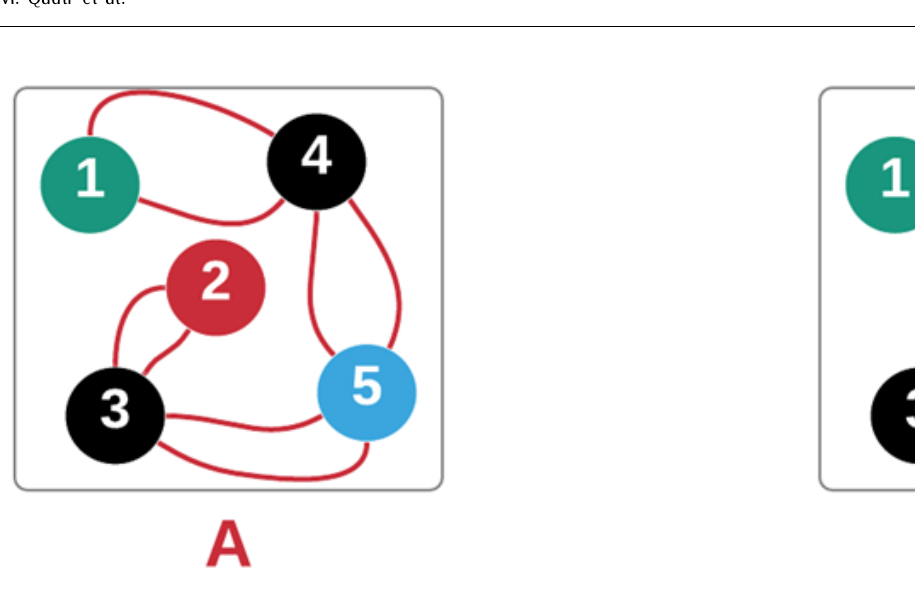
Figure 4. Example of graph with multiple edges and without multiple edges.